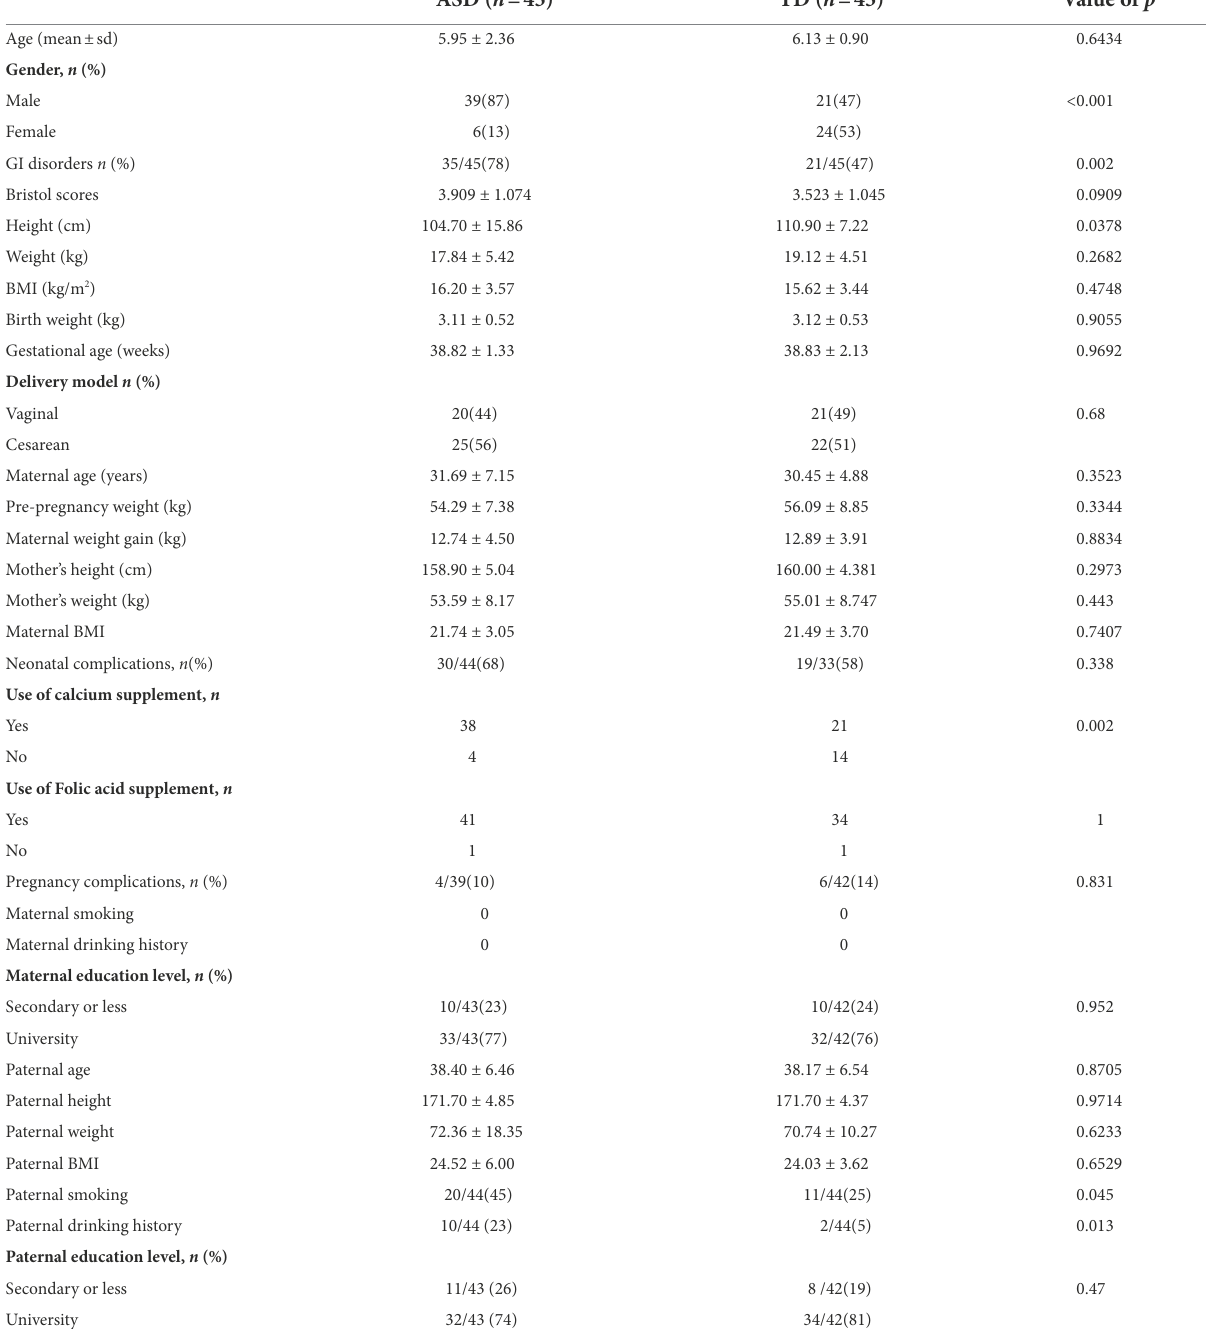
TABLE 1 Summary of subject demographics and